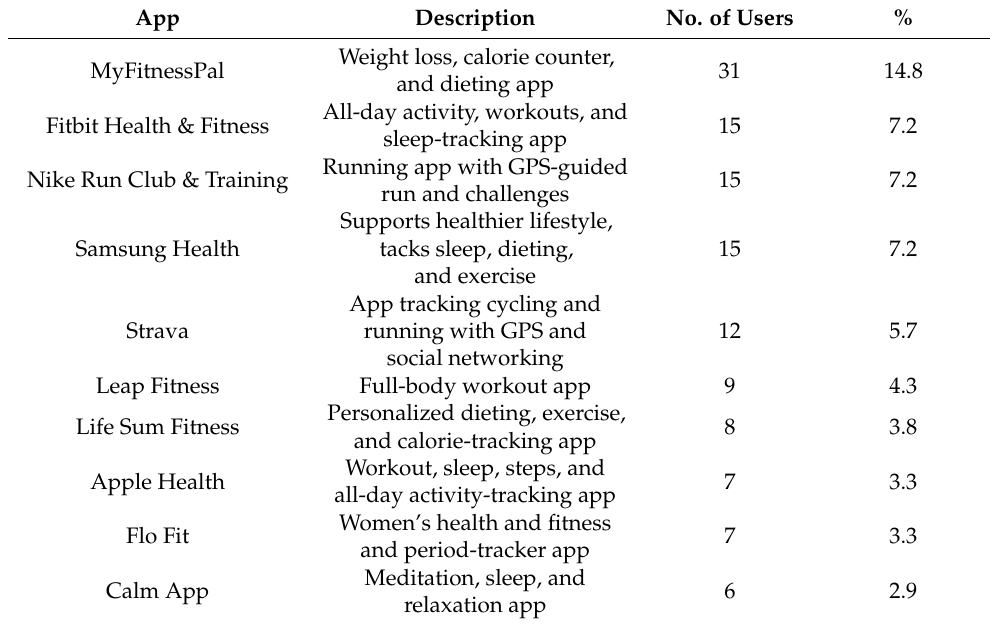
Table 3. Ten commonly used fitness